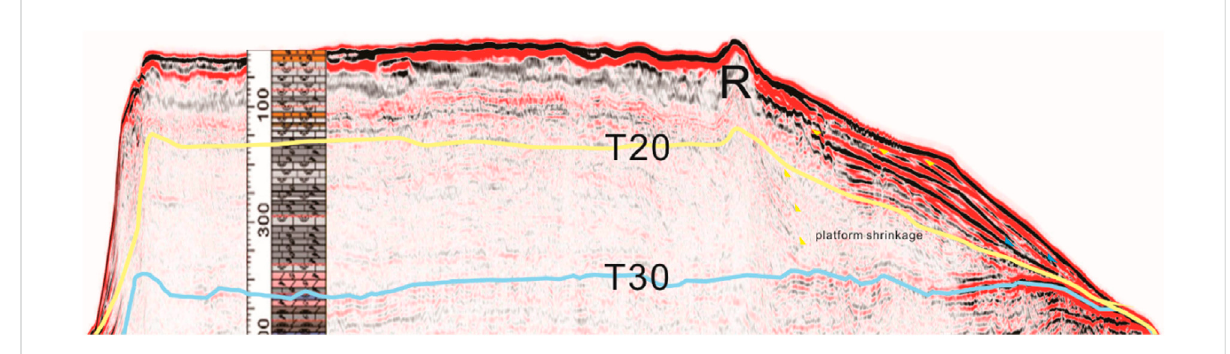
Interpreted seismic pro fi le XDS01, showing platform shrinkage at the end of the